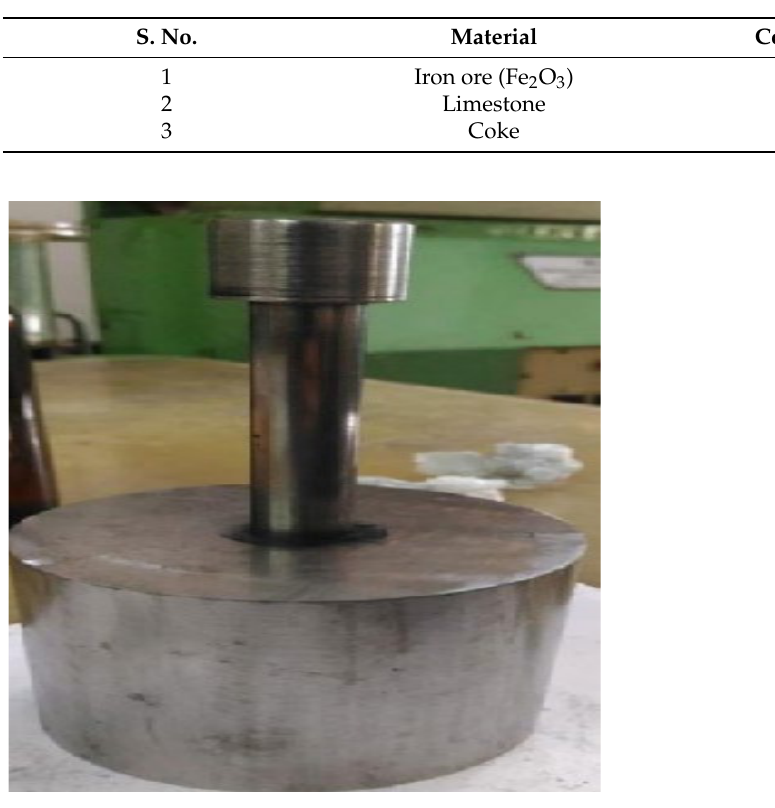
Figure 3. Powder form of hematite. Table 1. Composition of the material.